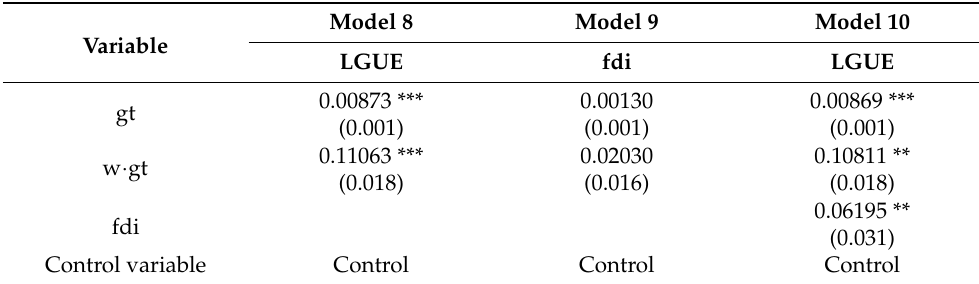
Table 6. Mechanism test results (Local investment